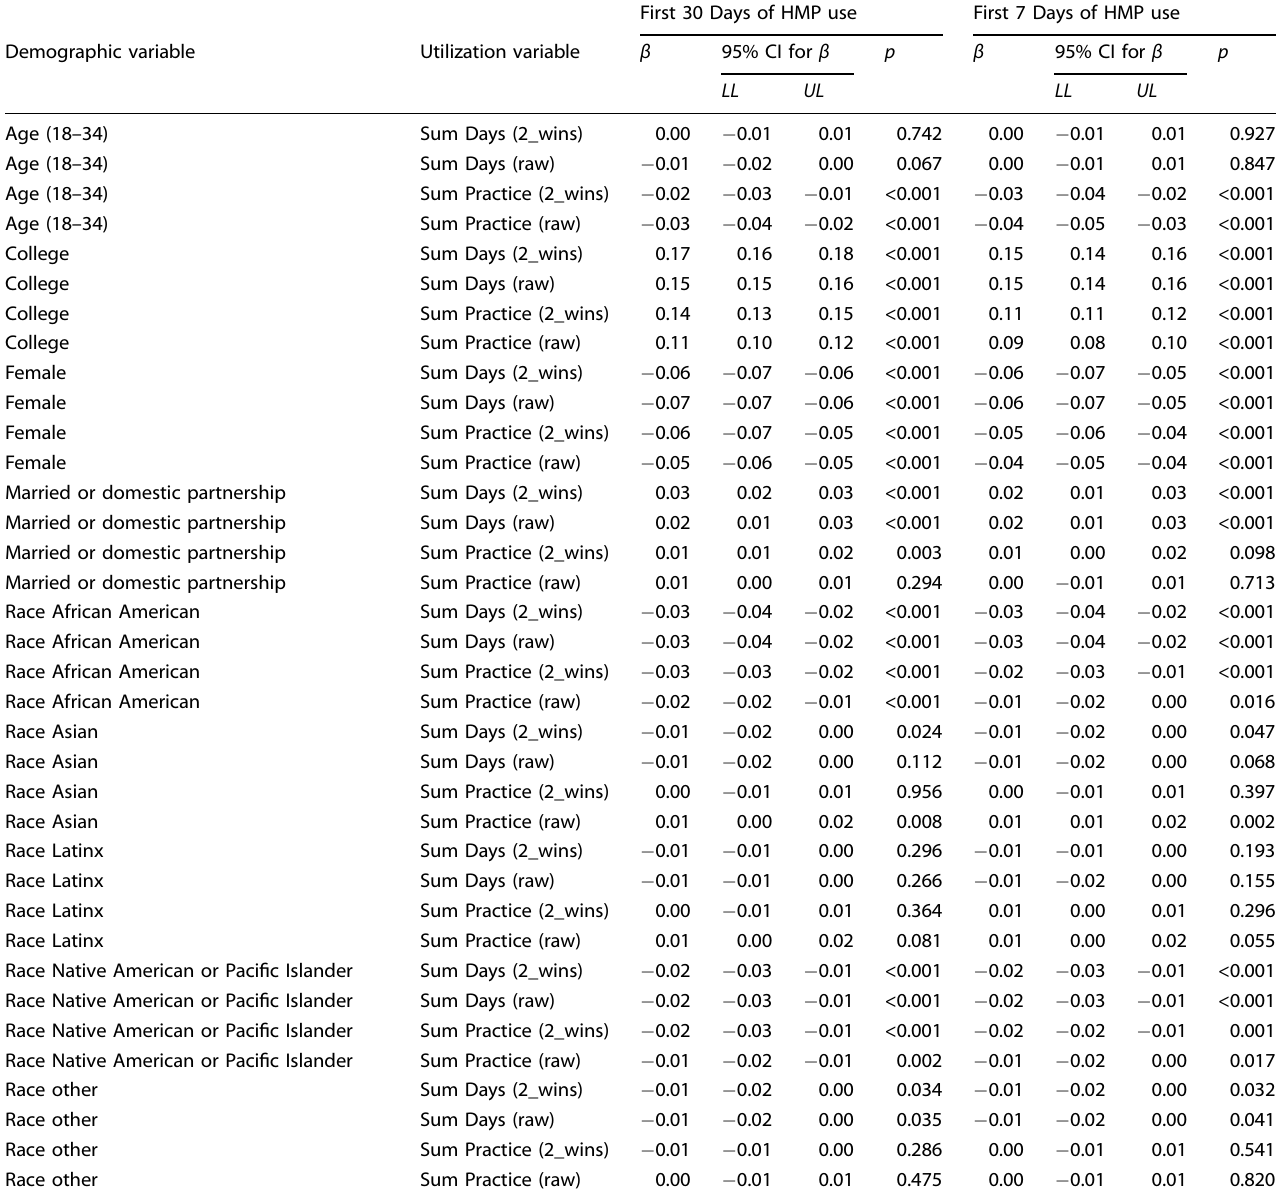
Table 3. Standardized regression coef fi cients for associations between demographic variables and continuous HMP utilization